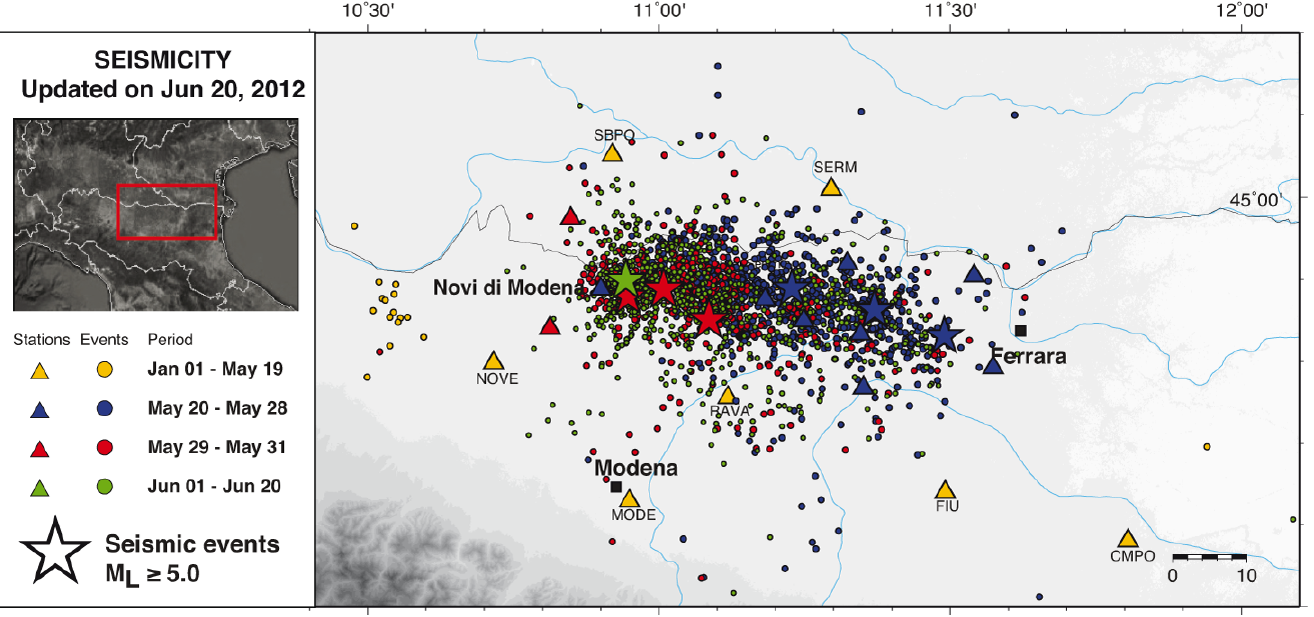
Figure 5. Earthquakes located by the INGV monitoring system for the period January to June, 2012. Black circles, towns and villages; colored triangles, seismic stations; circles and stars, earthquakes with magnitude >5.0. Earthquakes and stations are color-coded according to occurrence/deployment time relative to the scale on the legend.